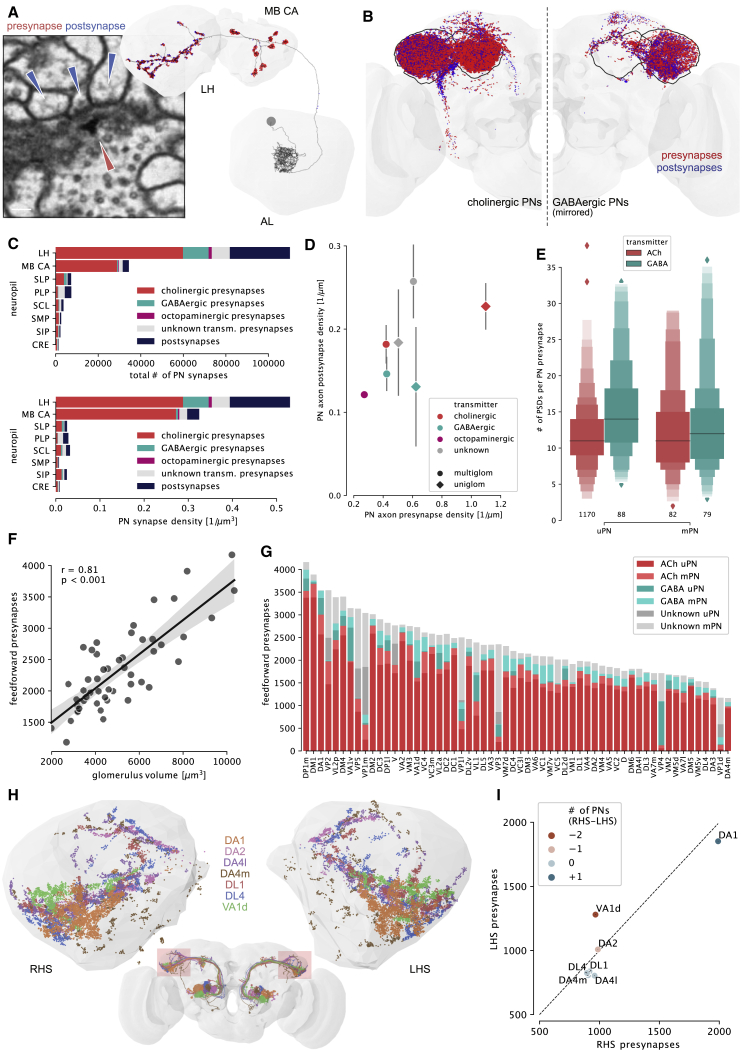
Third-Order Targets of Olfactory Feedforward Drive(A) Axonal pre- (outputs, red arrow) and postsynaptic (inputs, blue arrows) sites for exemplar PN.(B) Spatial distribution of pre- and postsynapses for cholinergic and GABAergic PNs (see Figure S2A for Octopamine and unknown transmitter).(C) Synapse number (top) and density (bottom) by target neuropil. LH and CA are main targets of feedforward olfactory drive. Most modulatory input onto PN axons occurs in LH.(D) Synapse densities along axon. Presynapse densities vary strongly: uniglomerular, cholinergic PNs have more than twice the density of GABAergic PNs. Error bars represent SEM.(E) Number of postsynaptic densities (PSDs) per LH synapse (polyadicity). Letter-value plot encodes distribution of data by showing additional quantiles [33]; black line represents mean; numbers below plots are synapses sampled.(F) Glomerulus volume strongly correlates with the number of feedforward PN synapses (Pearson).(G) Feedforward synapse budget per glomerulus. Glomeruli differ widely in the proportions of excitation to inhibition and uni- to multiglomerular synapse budgets.(H) Synapses of left (LHS) and right (RHS) homologs of 7 uPN types in the LH.(I) Comparison of left and right presynapse counts between uPN types in (H). Synapse numbers are consistent even in case of mismatches in number of cells.See also Figure S2; Data S1.